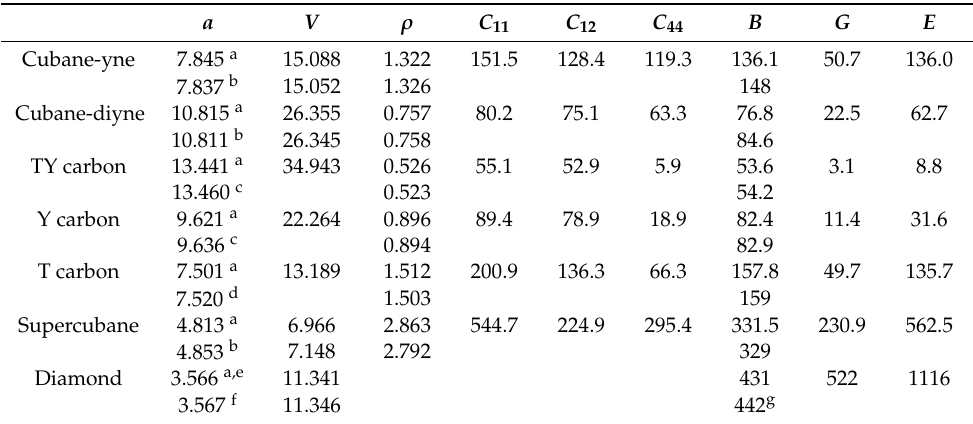
Table 1. The lattice parameters (Å), volumes of the conventional cell (Å 3 ), elastic constants (GPa), and elastic moduli (GPa) of the investigated carbon